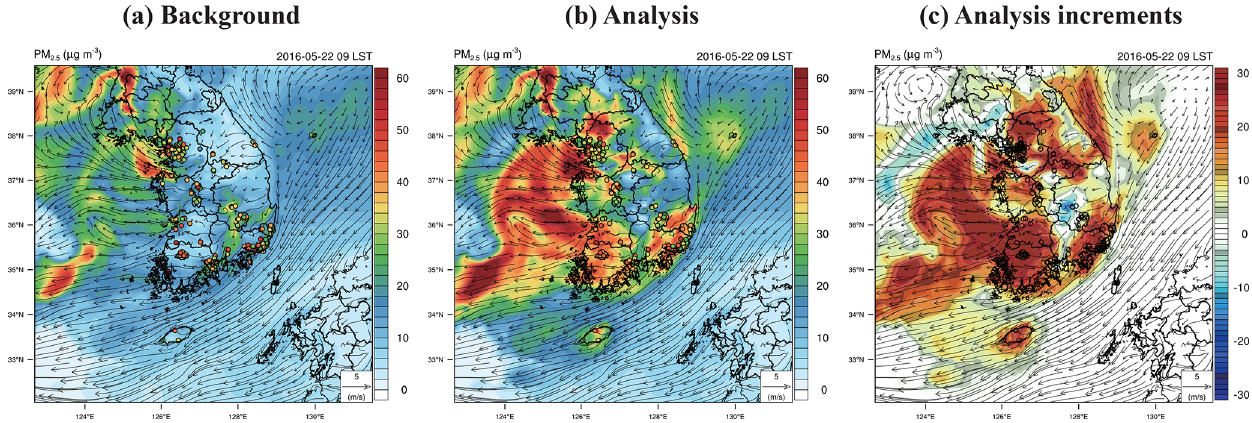
Figure 4. Snapshots of the horizontal distributions of PM 2 . 5 before ( a background) and after ( b analysis) the application of the EnKF technique at 00:00UTC on 22 May 2016. The observed concentrations are also shown on the map with the same color scales as contour values. In the right-hand panel (c) , the analysis increments are also presented, and flow-dependent corrections are visible when the wind vectors are overlaid with the analysis increments. The big island in the Southern Sea of the Korean Peninsula is Jeju Island, where the flow-dependent behavior can be